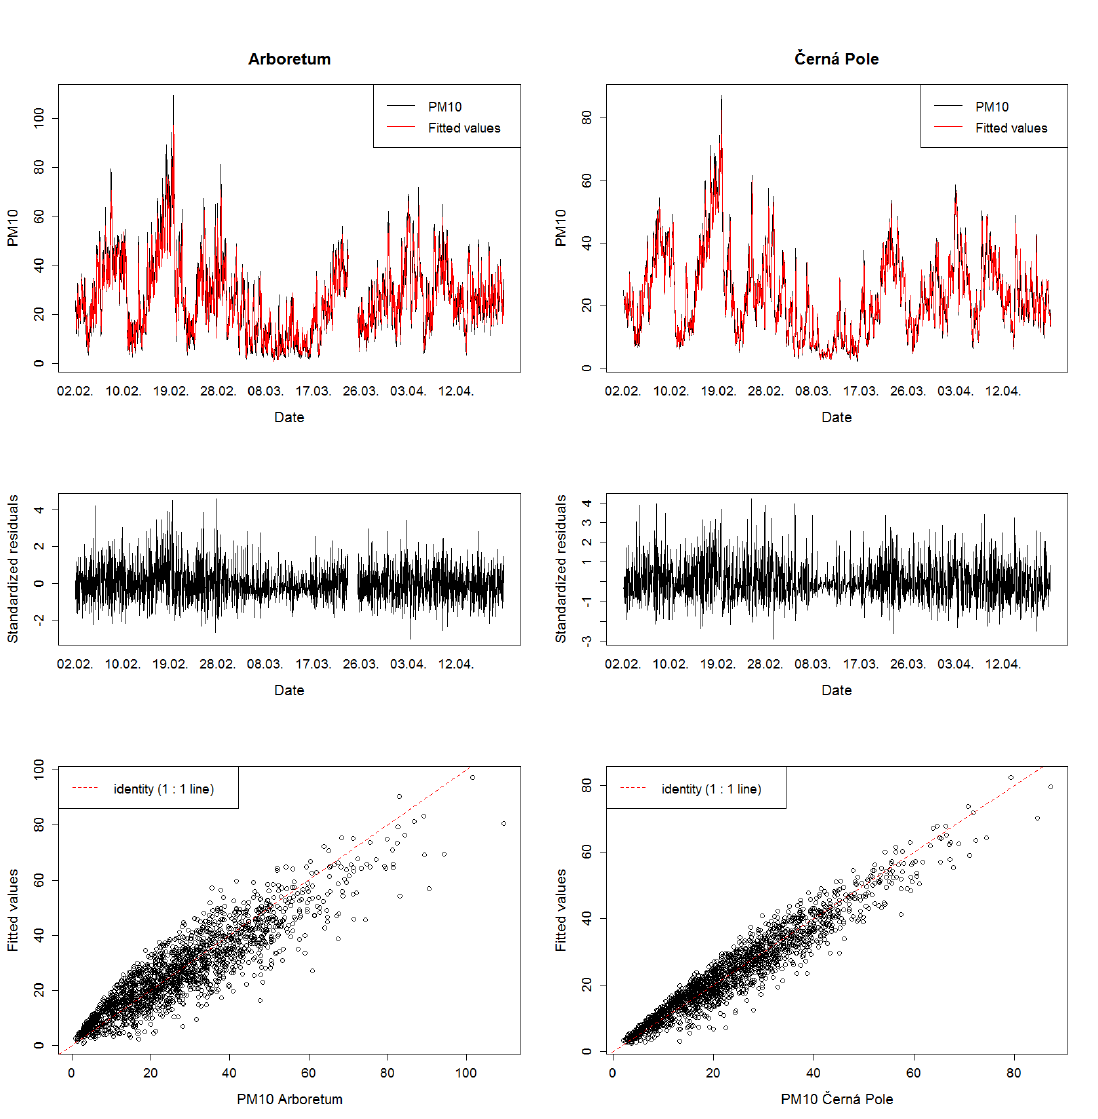
Figure 6. Fitted models, standardized residuals, and measured vs. fitted values, PM 10 in µ g · m − 3